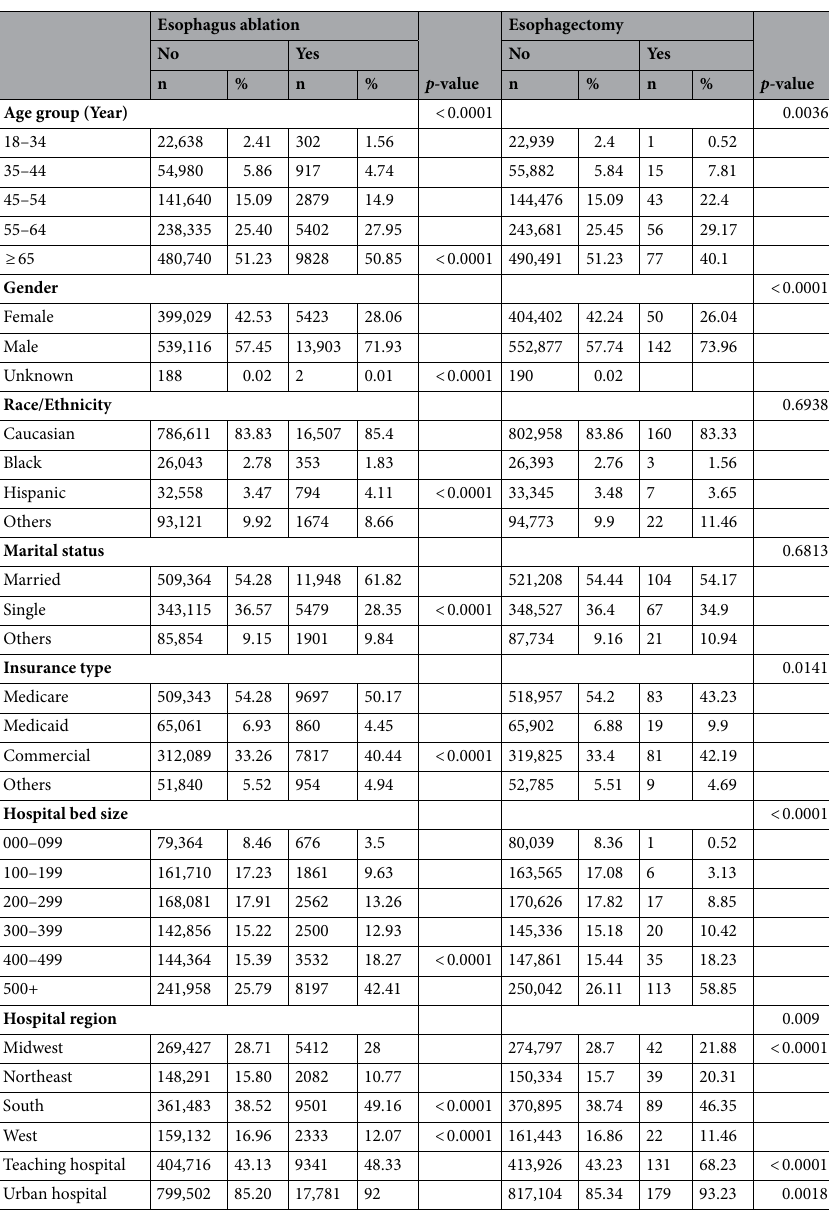
esophagus ablation or